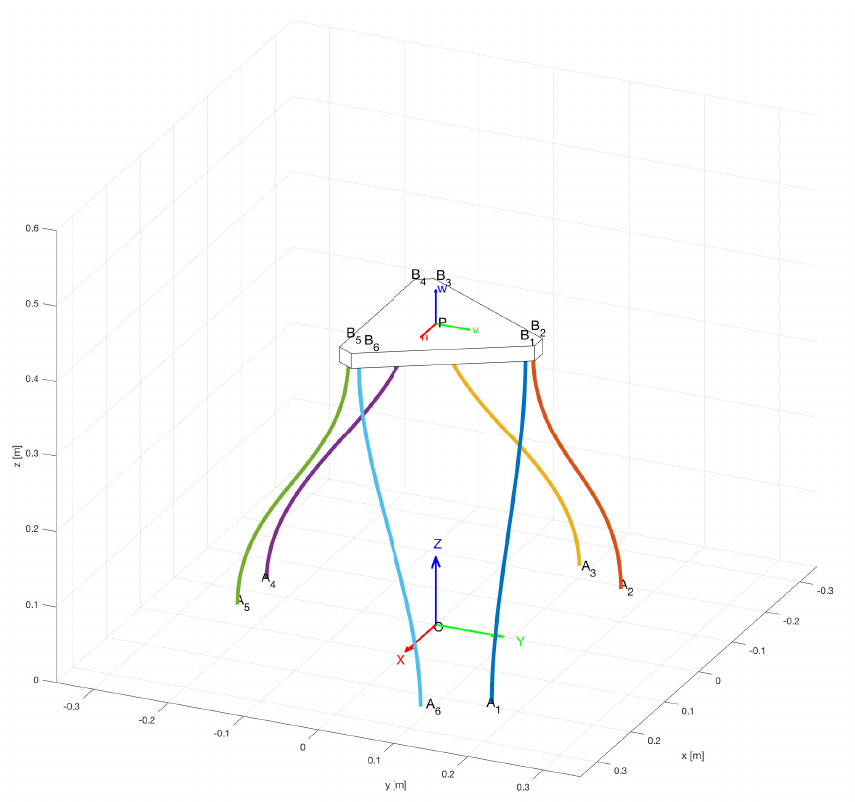
Figure 2. Flexible hexapod: 6 PFR